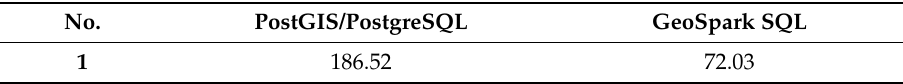
Table 19. Performance of spatial join queries (in seconds).